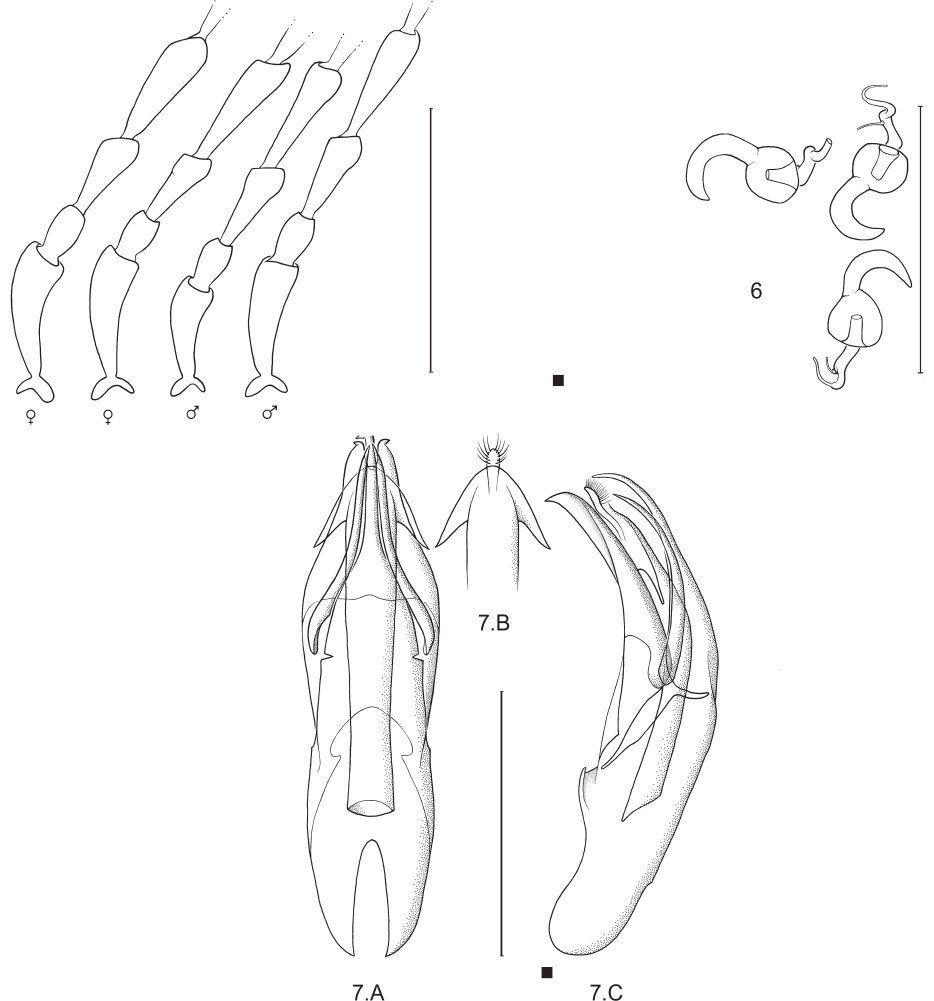
Figs 5-7. Oosagitta angolensis comb. nov. 5 . Basal four antennomeres of 2 ♂♂ and 2 ♀♀. 6 . Spermathecae of 3 ♀♀. 7 . Median lobe: A . Dorsal. B . Detail: apex of endophallus. C . Lateral. Scale bars = 1